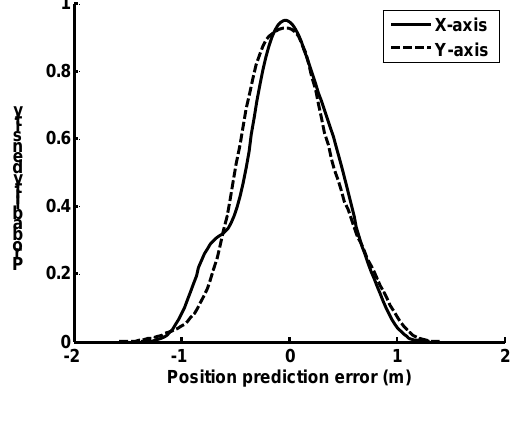
Figure 7. Probability density of position prediction error on X-axis and